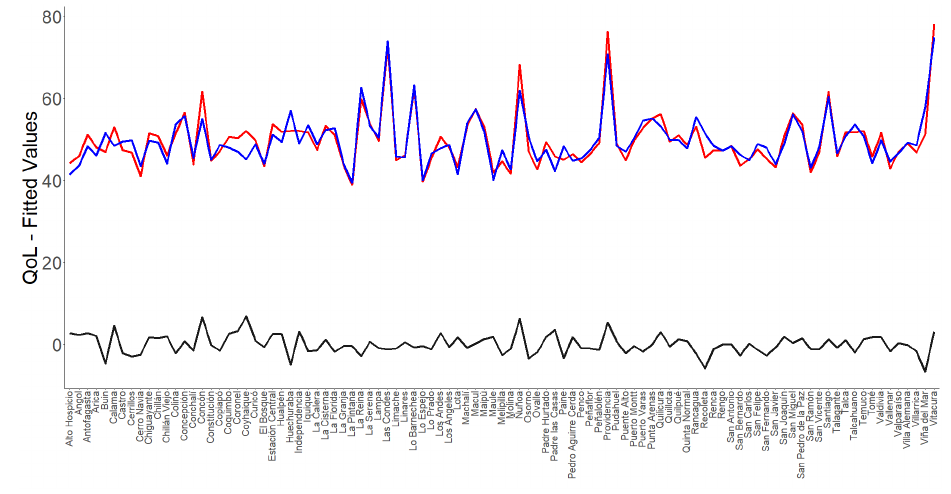
Figure 11. Fitted and actual values of quality of life considering